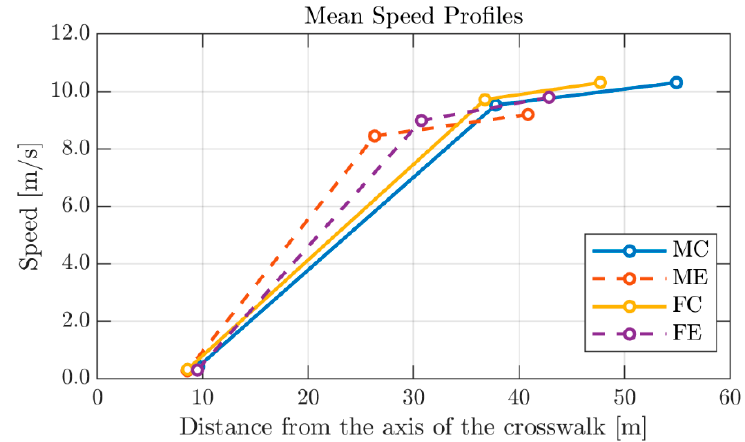
Figure 3. Drivers’ mean speed profiles. Legend : MC: male drivers in the control group; ME: male drivers in the experimental group; FC: female drivers in the control group; FE: female drivers in the experimental group.